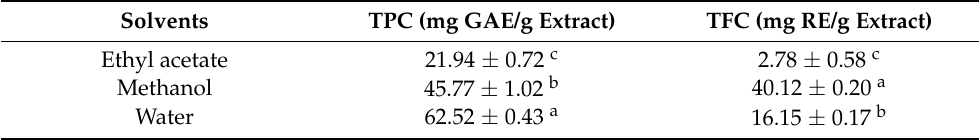
Table 1. Total phenolic (TPC) and flavonoid content (TFC) of the tested extracts. Solvents